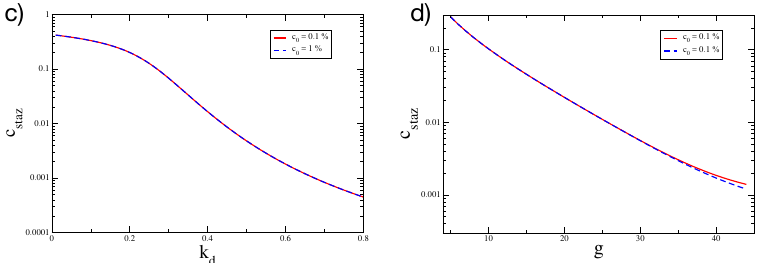
Figure A1. The size c staz of the steady state CSC concentration as a function ( a ) of the switching rate σ , ( b ) of the rate difference (cid:101) , ( c ) of the rate k d and ( d ) of the number g of generations of CC.